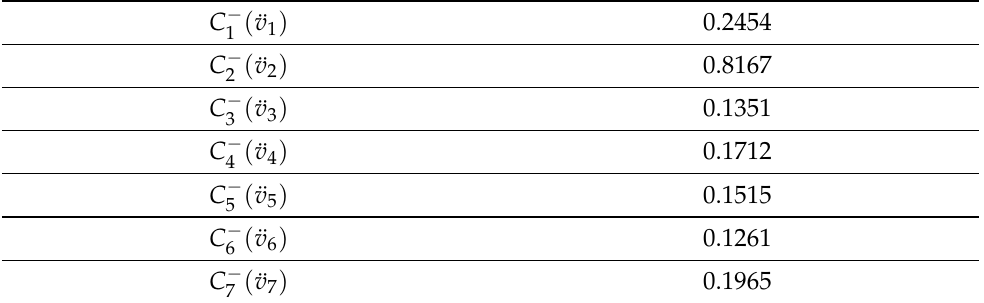
Table 20. Closeness coefficient.